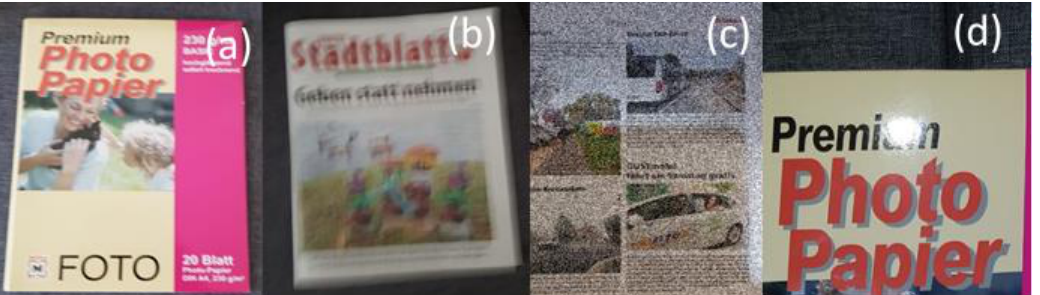
Figure 2. Main distortion problems encountered in document images: ( a ) a document image, usually taken from a mobile phone with focus blur distortion; ( b ) a document image with motion blur; ( c ) a document image with salt and pepper noise; ( d ) a document image with spotlight blocking/disturbing the readability of part of the text contained in the document. (Source: our own pictures.)